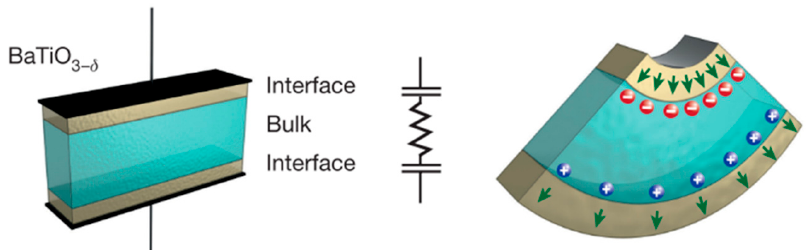
Figure 13. Schematic of a semiconductive BaTiO 3 −δ crystal forming barrier layers on the surfaces, and the barrier layer theory enhancing surface piezoelectricity when bending the semiconductive BaTiO 3 −δ crystal. Reprinted with permission from [77]. Copyright 2016 Springer Nature.